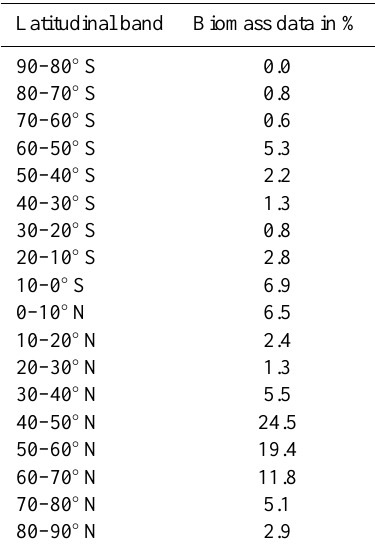
Table 1. Latitudinal distribution of biomass data in %. Latitudinal band Biomass data in